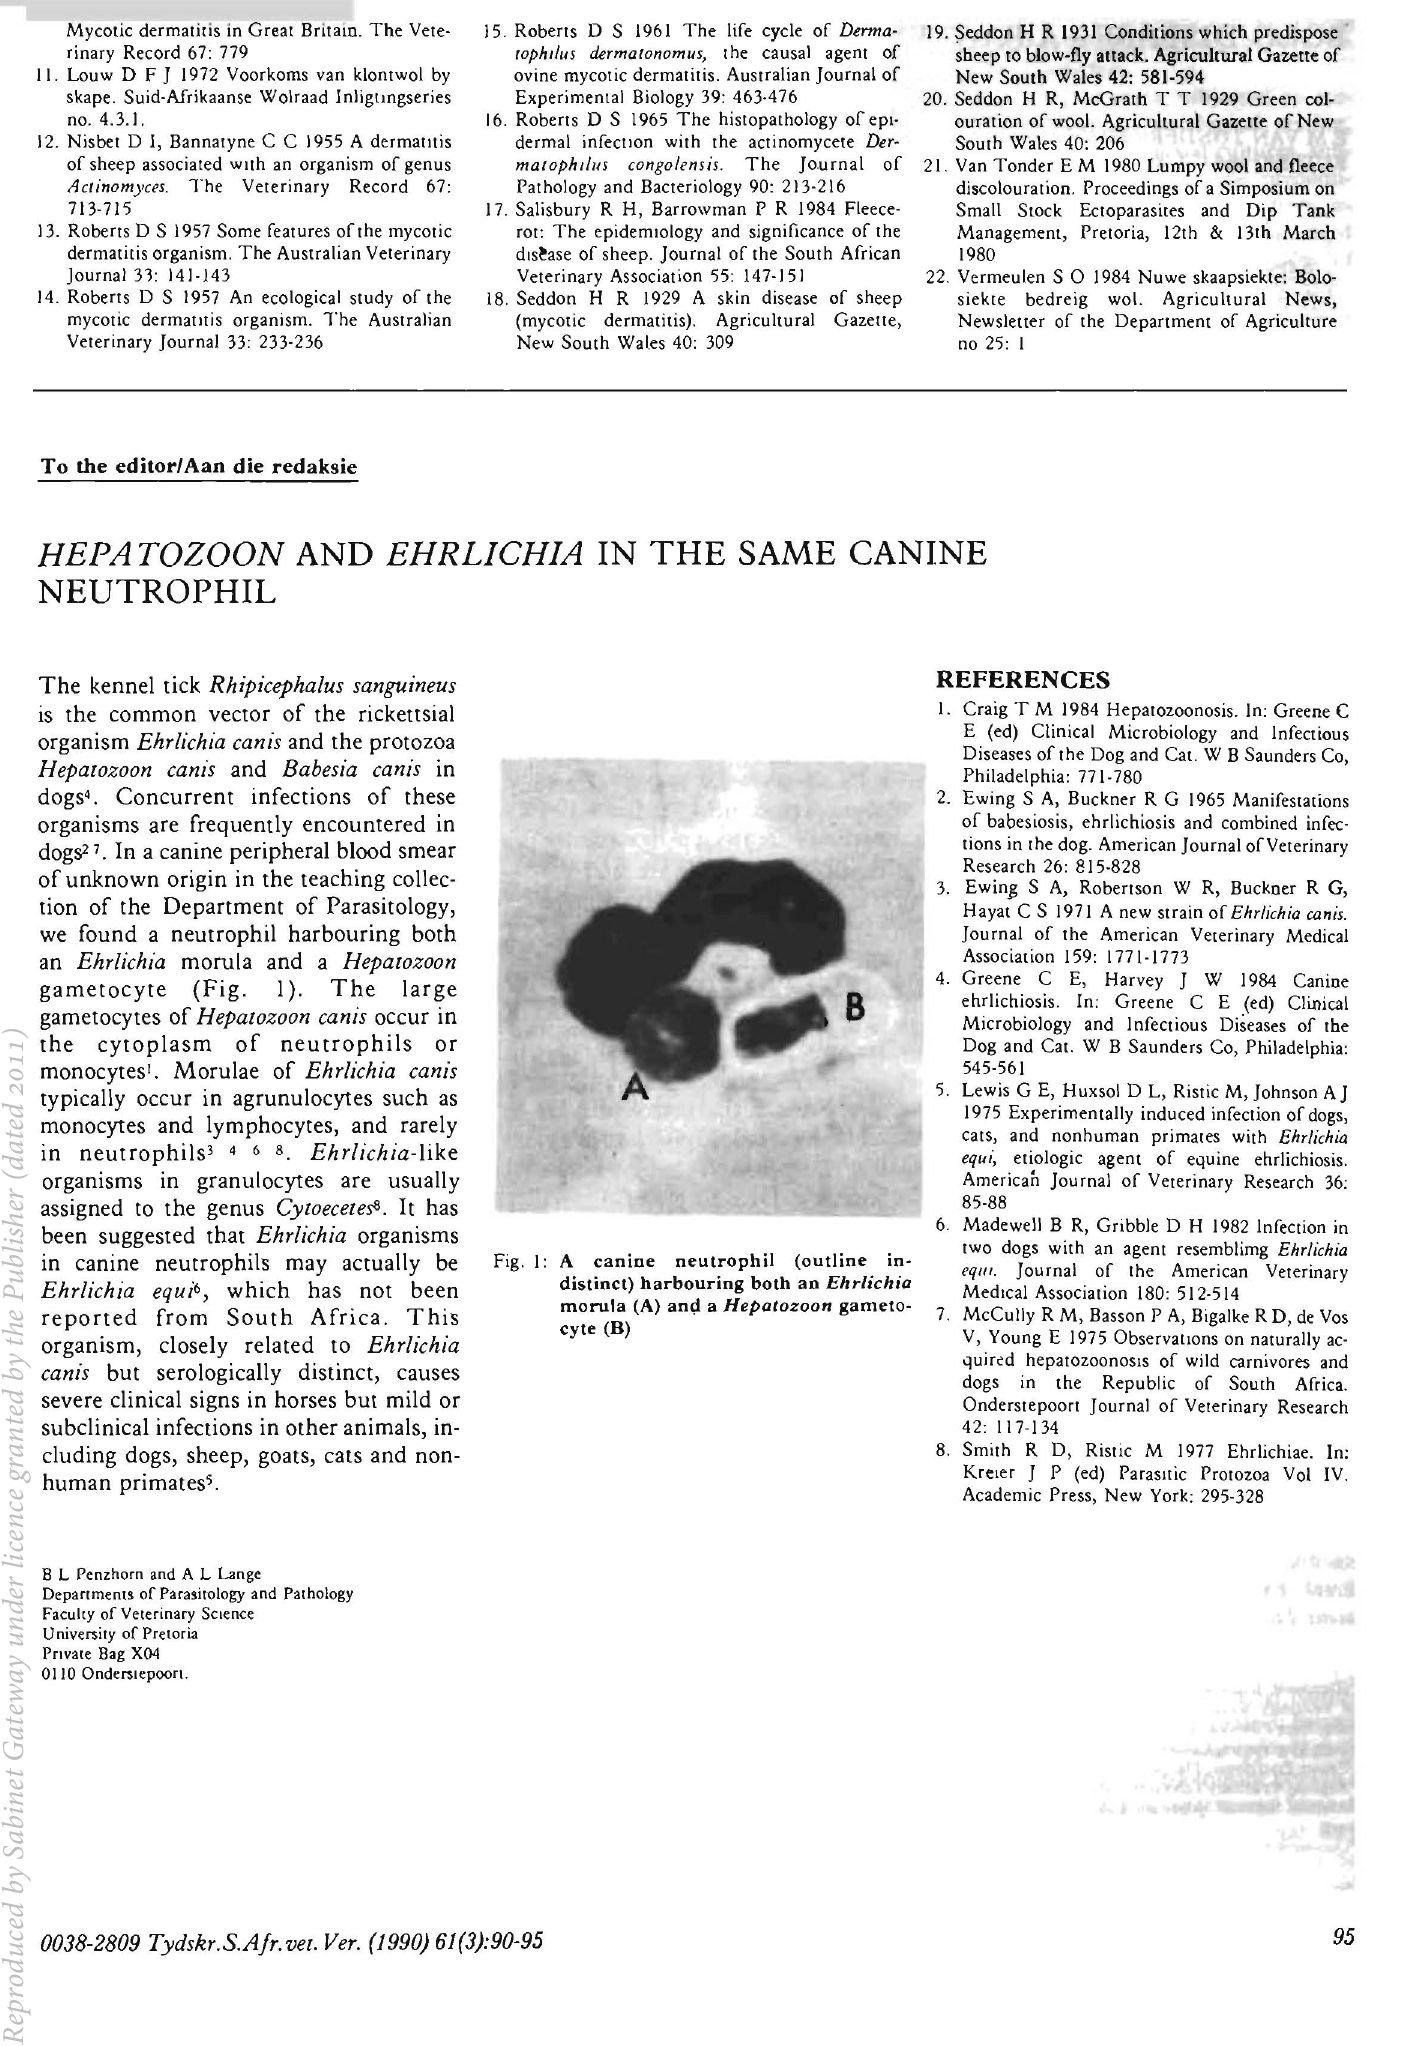
Fig. I: A canine neutrophil (outline in distinct) harbouring both an Ehrlichia morula (A) anc;l. a Hepatozoon gameto cyte